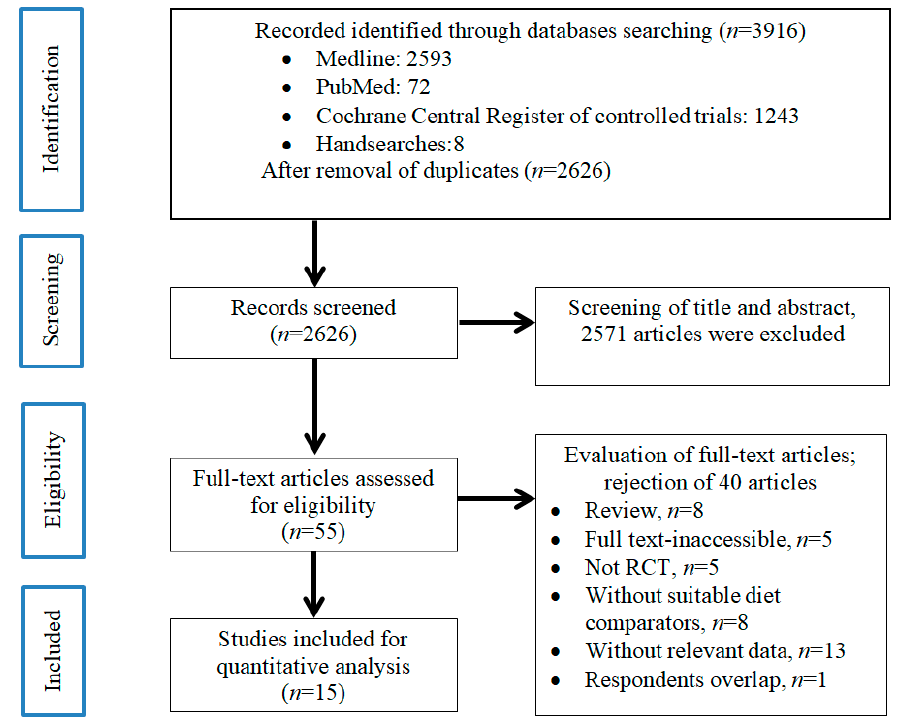
Figure 1. Preferred Reporting Items for Systematic Reviews and Meta-analyses (PRISMA) flow diagram of the literature screening process.